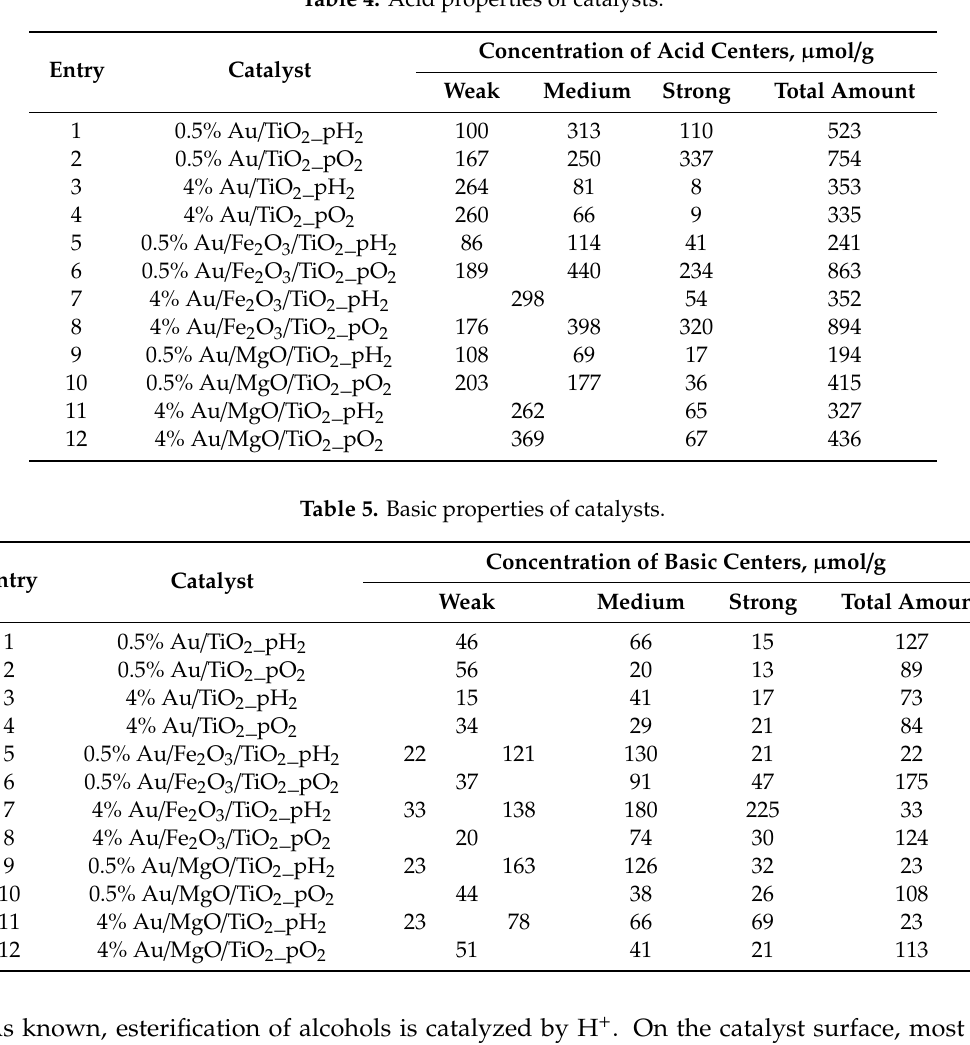
Table 4. Acid properties of catalysts.